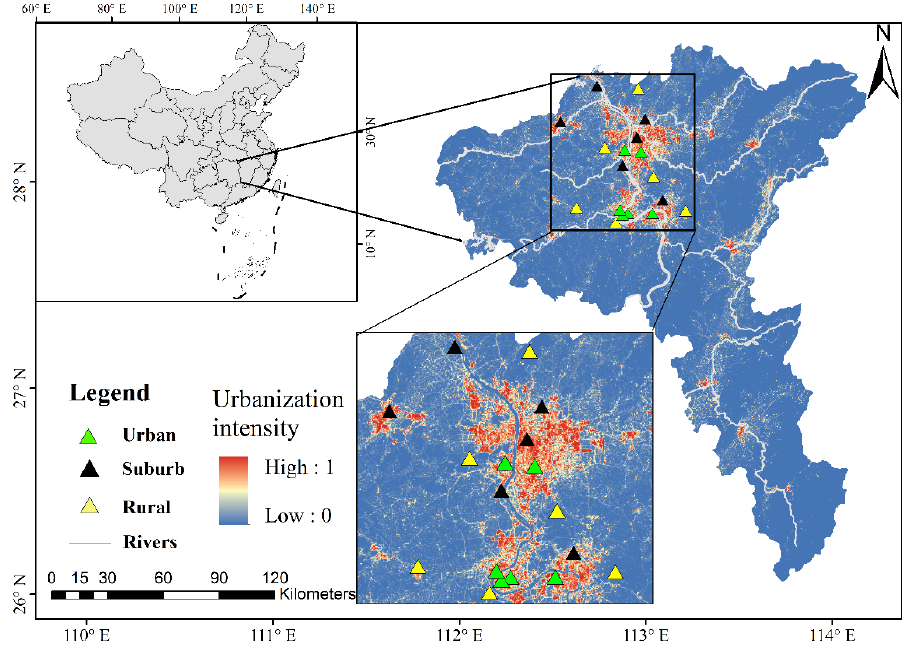
Figure 1. Map of sampling sites along the rural-suburban-urban gradient in Chang-Zhu-Tan agglomeration. The yellow triangles represent rural areas, black triangles represent suburb areas, and green triangles represent urban areas.